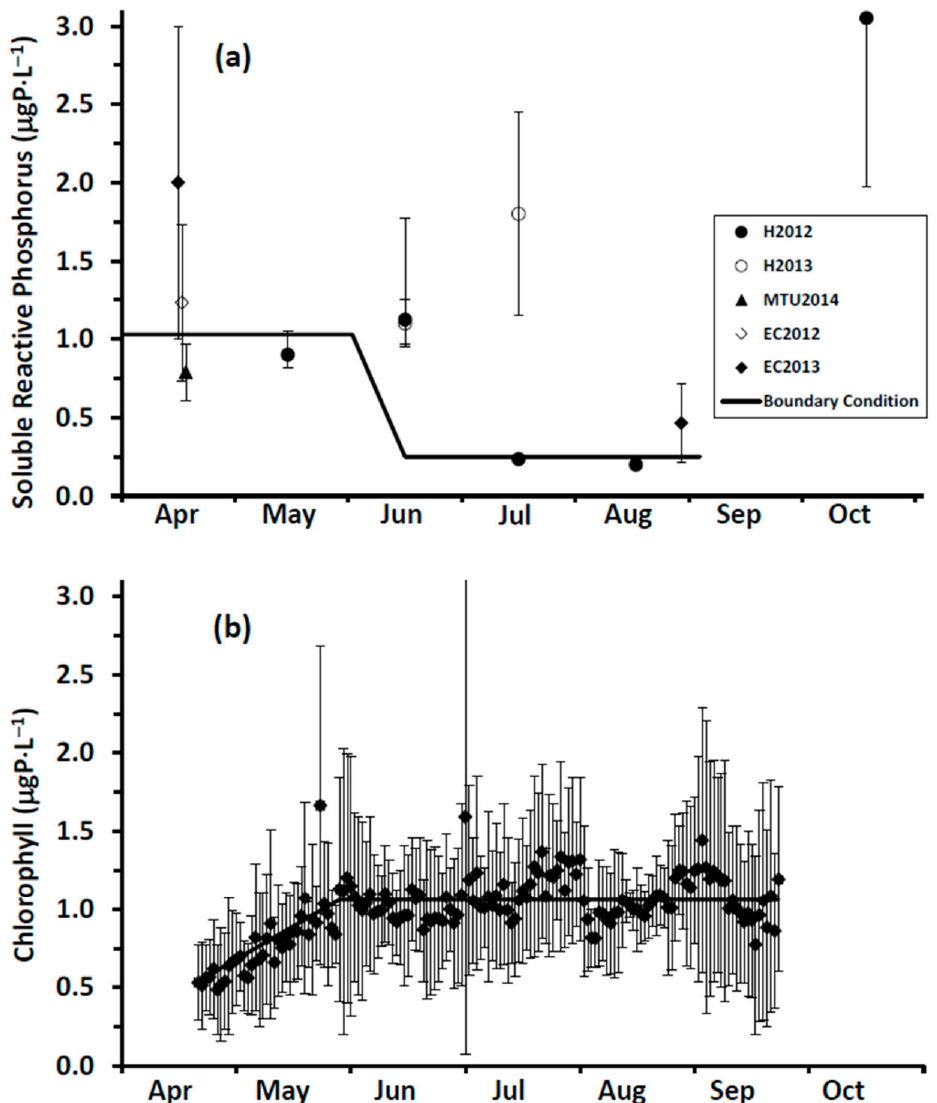
Figure 6. Determination of boundary conditions: ( a ) soluble reactive phosphorus and ( b ) chlorophyll; with bars representing the standard deviation of the mean daily